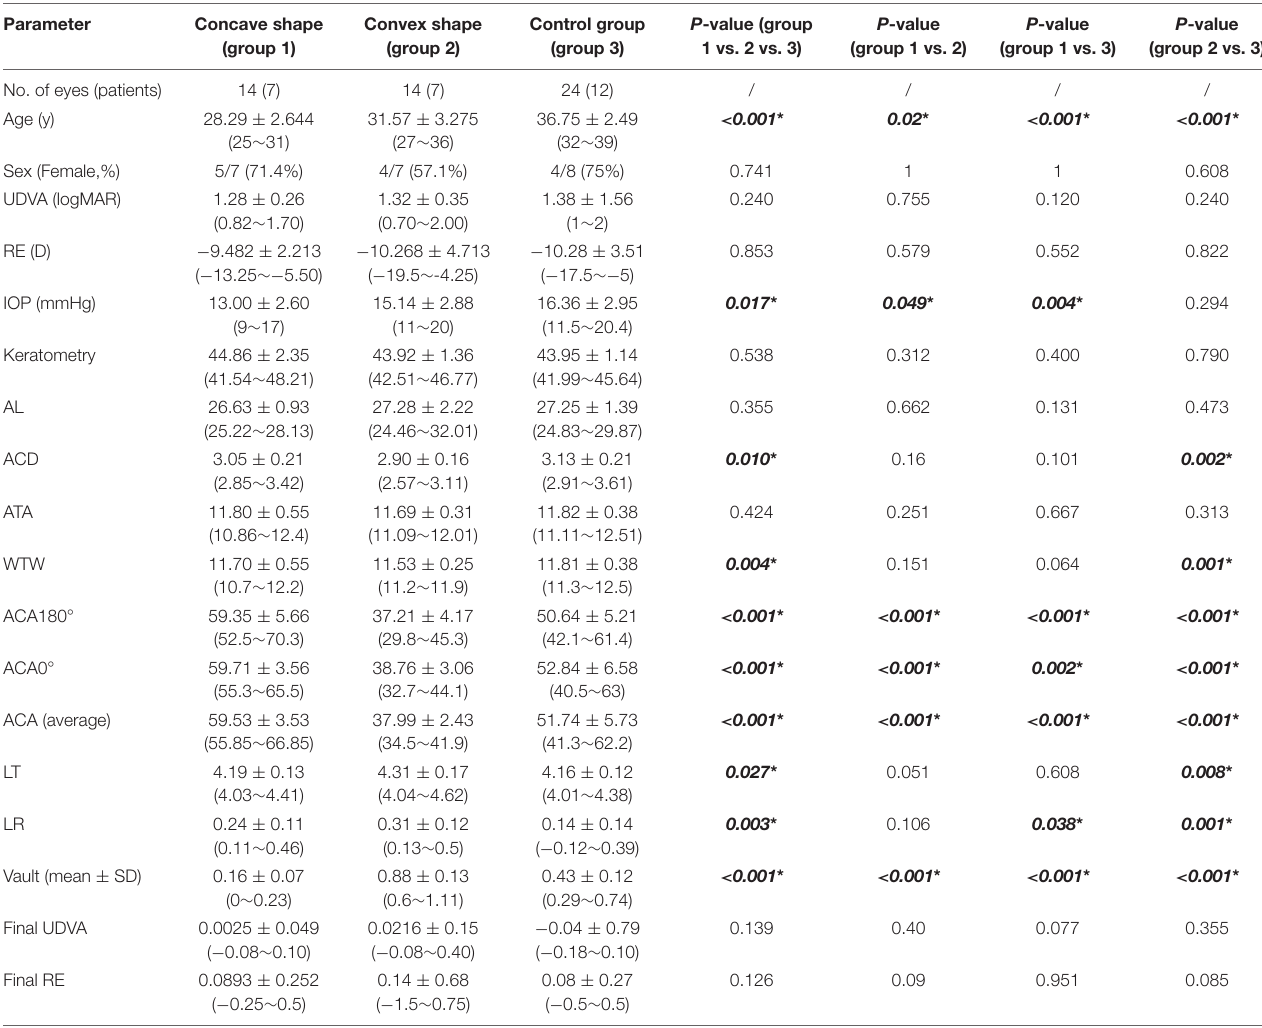
TABLE 1 | Demographic and clinical baseline characteristics in patients with concave shape iris and convex shape iris. Parameter